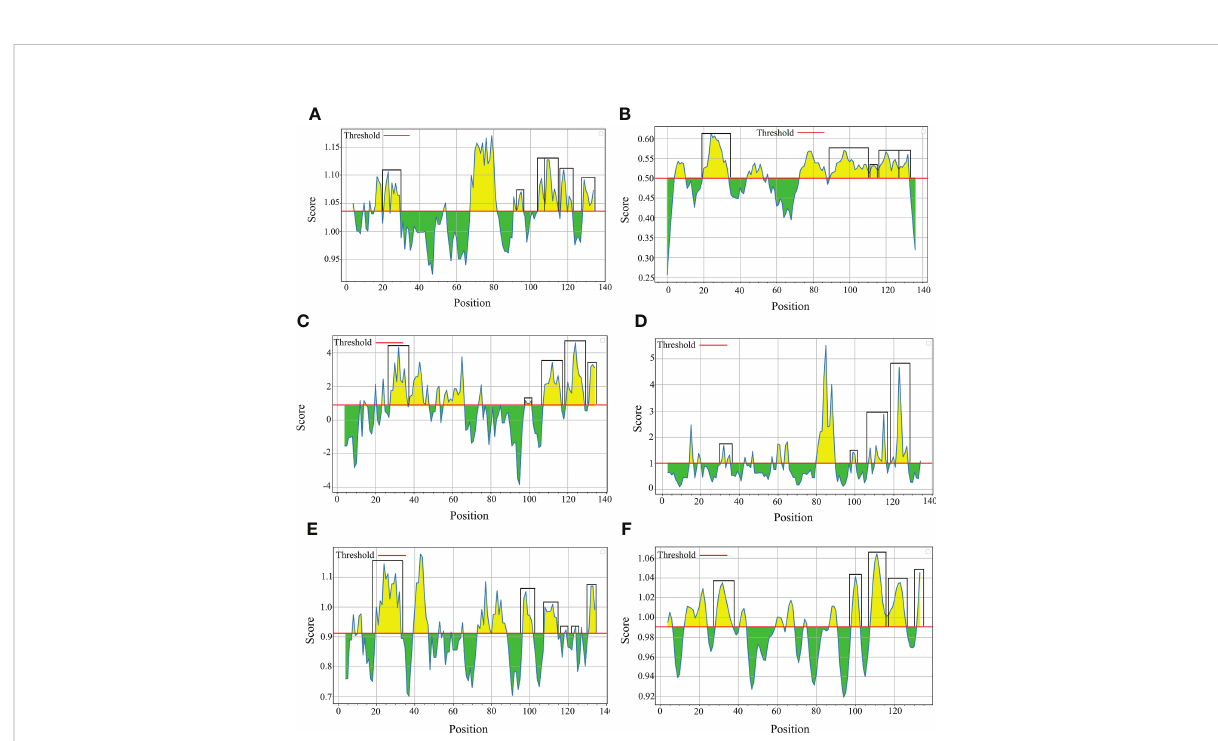
FIGURE 6 The physicochemical properties of B bigemina rap-1a protein were assessed based on Kolaskar & Tongaonkar antigenicity (A) , BepiPred linear epitope (B) , Parker hydrophilicity (C) , Emini surface accessibility (D) , Chou & Fasman Beta-turn (E) and Karplus & Schulz fl exibility prediction (F)